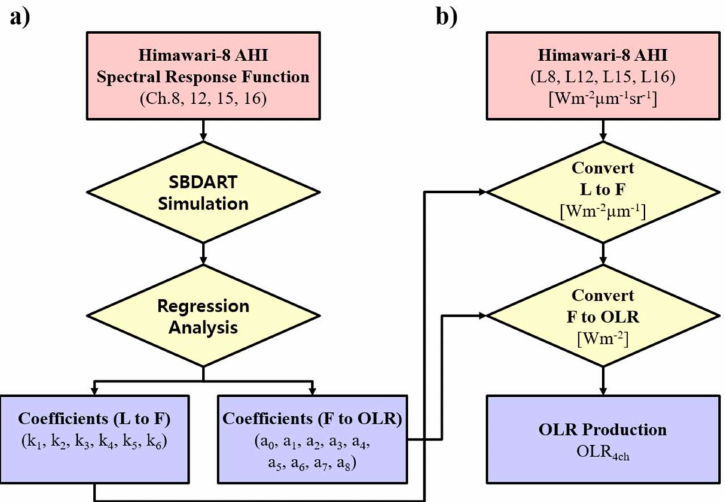
Figure 2. Flowchart of the algorithm used to calculate OLR using Himawari-8 AHI channel data and the algorithms used to calculate the regression coefficients ( a ) needed to convert between different types of radiation at different stages ( b ). L is the narrowband radiance and F is the narrowband